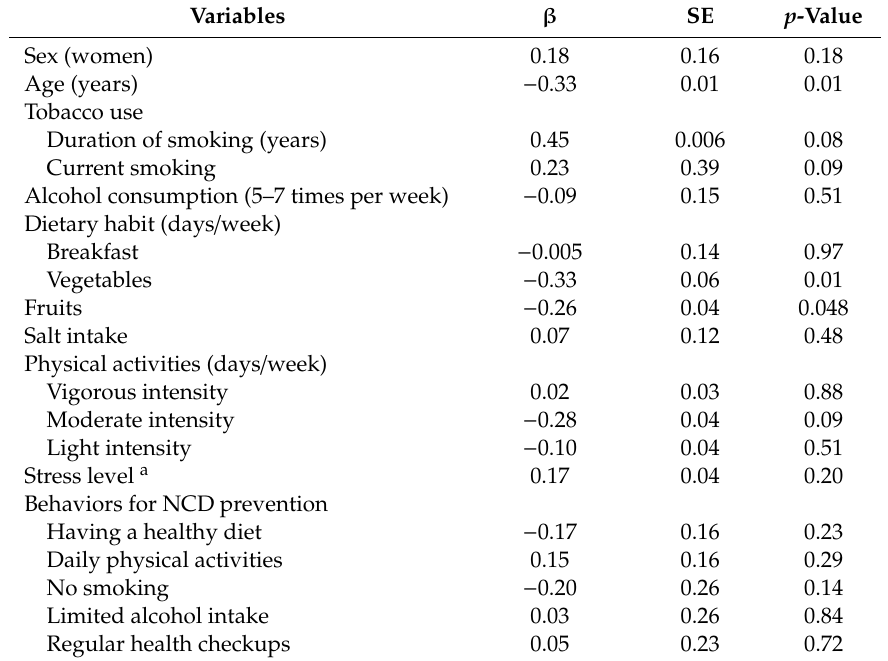
Table 6. Association between lifestyle and behaviors for NCD prevention and loneliness in Japanese older